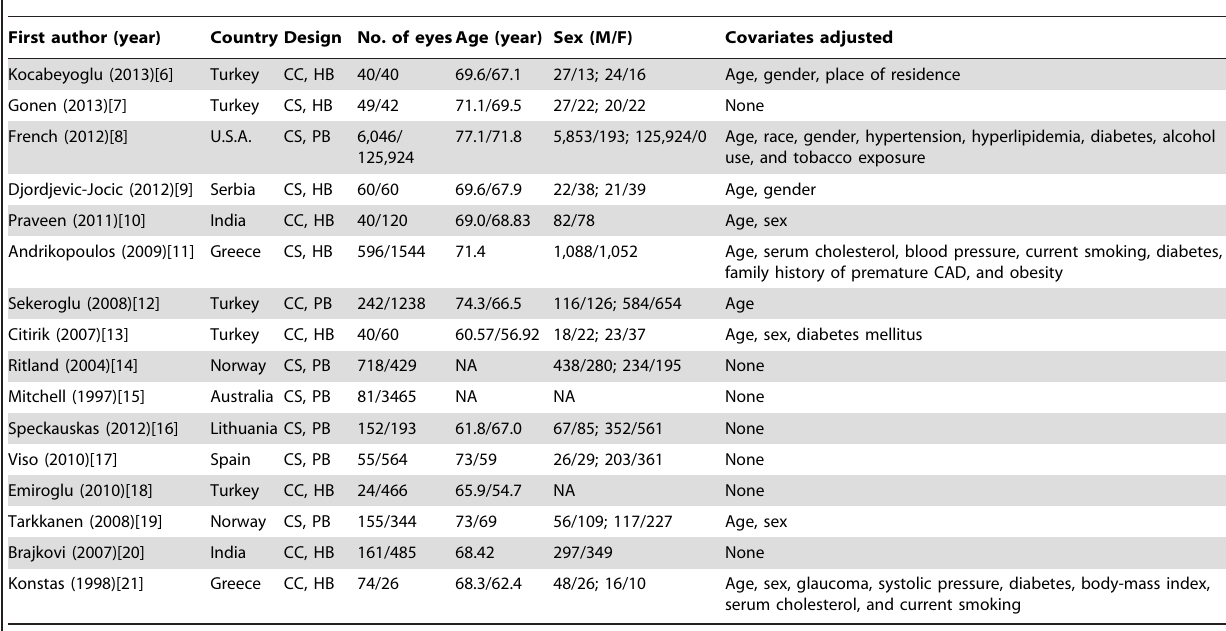
Table 1. Characteristics of studies included in the